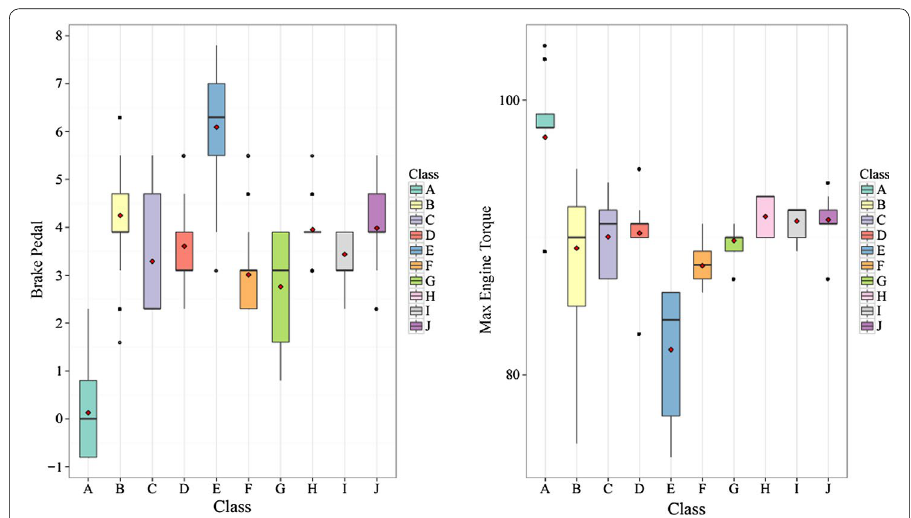
Fig. 8 Feature distribution according to drivers in parking lot